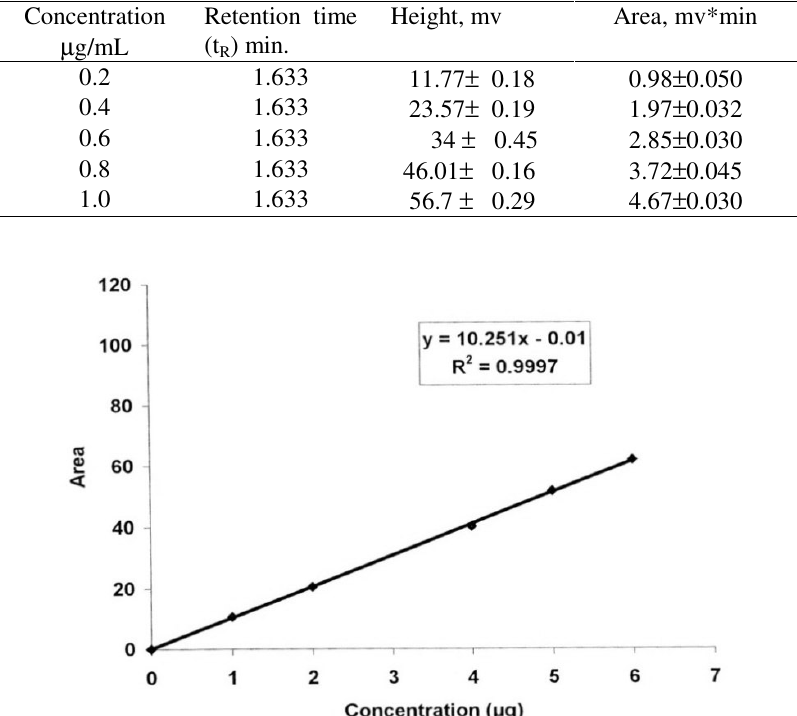
Table 5 . HPLC data obtained from the injection of samples prepared from alprazolam standard powder with given concentrations